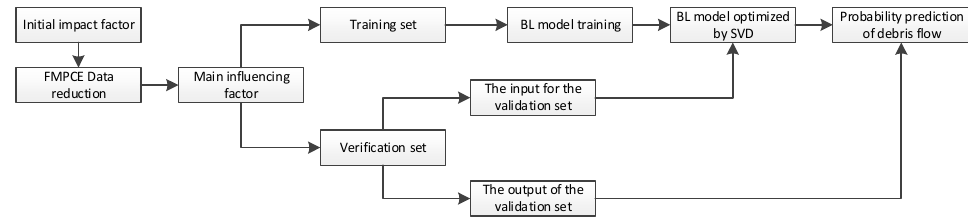
Figure 6. Research Figure 6. Research scheme.